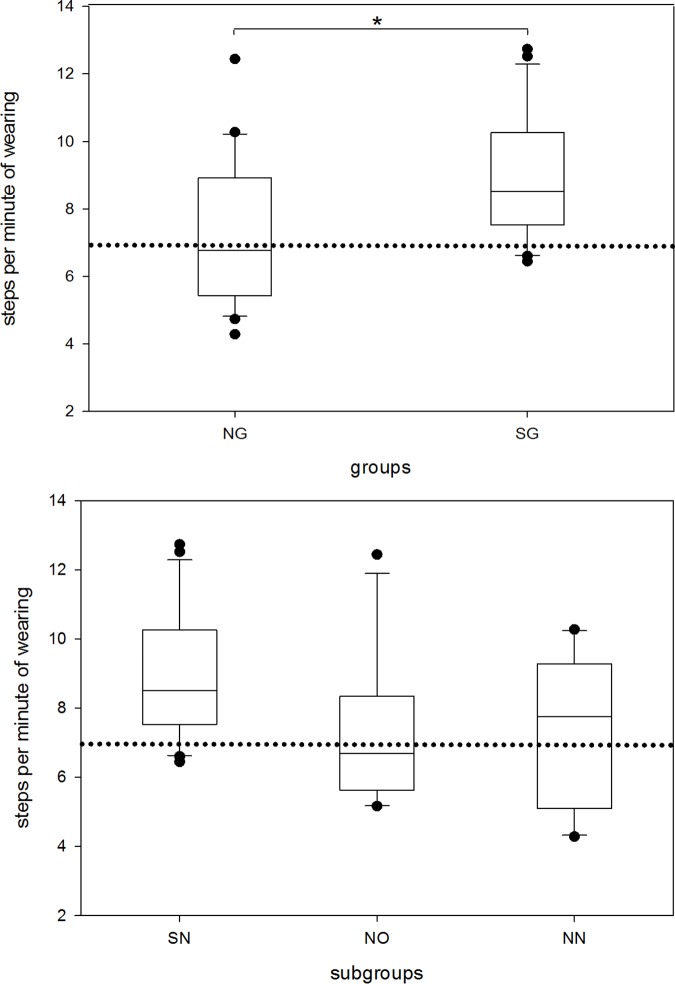
Overall steps per minute in non-shift and shift working group and subgroups.The boxes cover the first quartile on the bottom and the third quartile on the top. Whiskers reach from the minimum to the maximum value excluding outliers (illustrated by dots). Shift-working group and shift-working nursing-staff subgroup cover identical cohorts. Steps per minute were calculated based on the ratio of overall steps and overall armband wearing time in minutes. Dotted line represents the 10000 steps per day boundary (i.e. 6.94 steps·min-1). NG, non-shift-working group; SG, shift-working group; SN, shift-working nursing-staff subgroup; NO, non-shift-working office-staff subgroup; NN, non-shift-working nursing-staff subgroup *p<0.05.